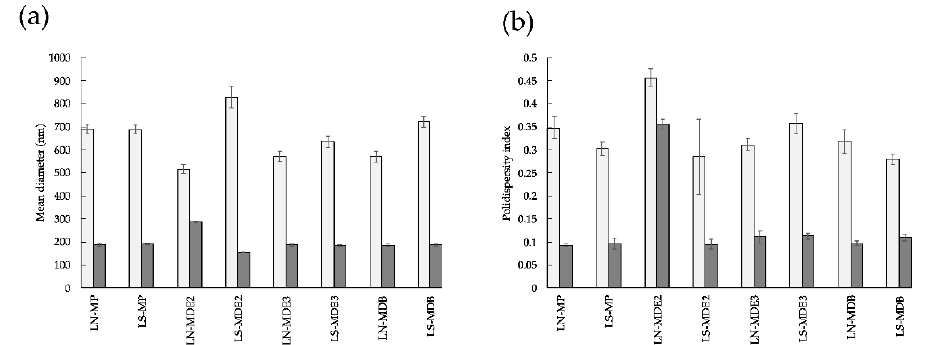
Figure 5. Dimensional parameters of the produced anionic liposomes obtained before (light gray) and after extrusion (dark gray). Mean diameters are expressed as Z-average ( a ) and dispersity index values ( b ).